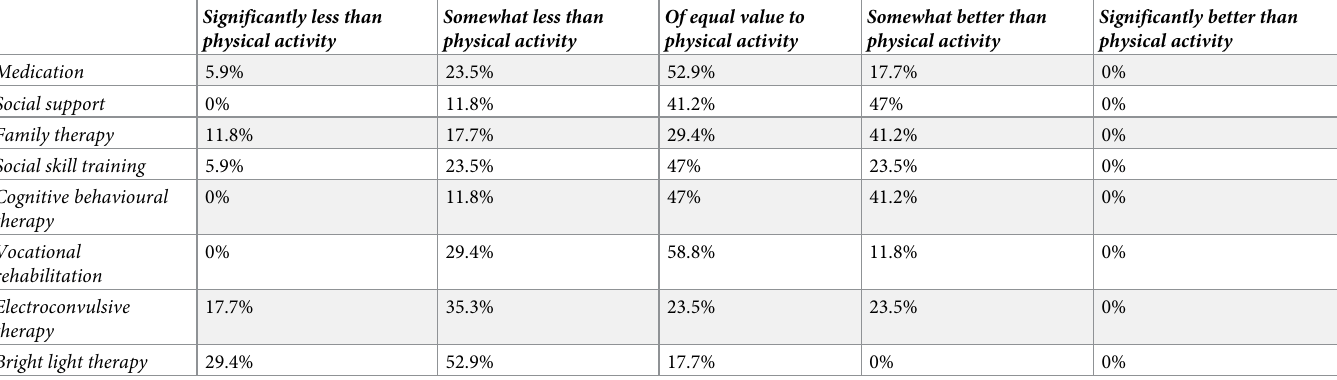
Table 2. Value of physical activity counselling compared with other types of treatment for mental illness, as perceived by mental health